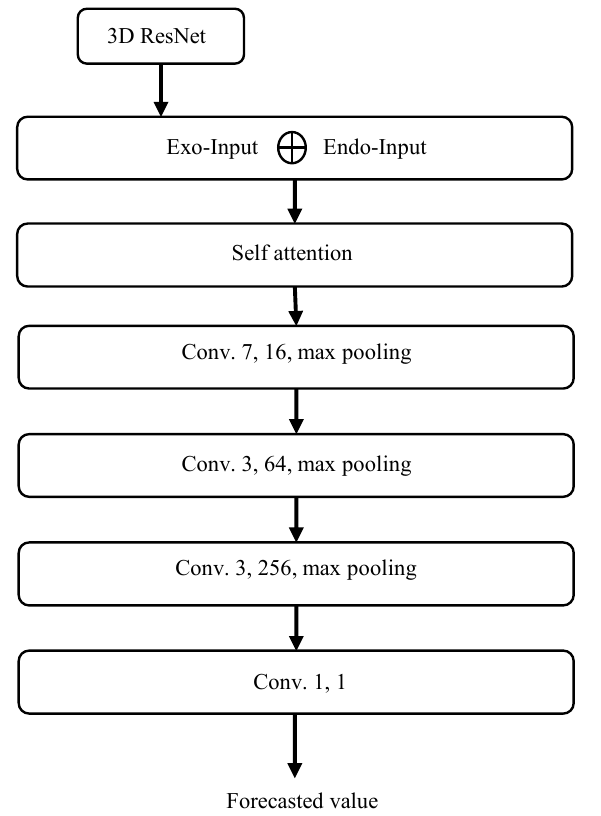
Figure 2. WSM architecture for 3D ResNet training where Conv. N , F indicates convolutional operation with kernel size N and output features with F channels.